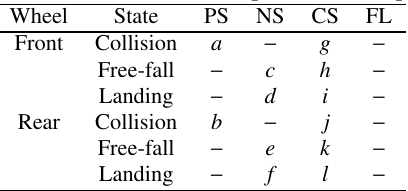
Table 1: Wheel state when passed each step